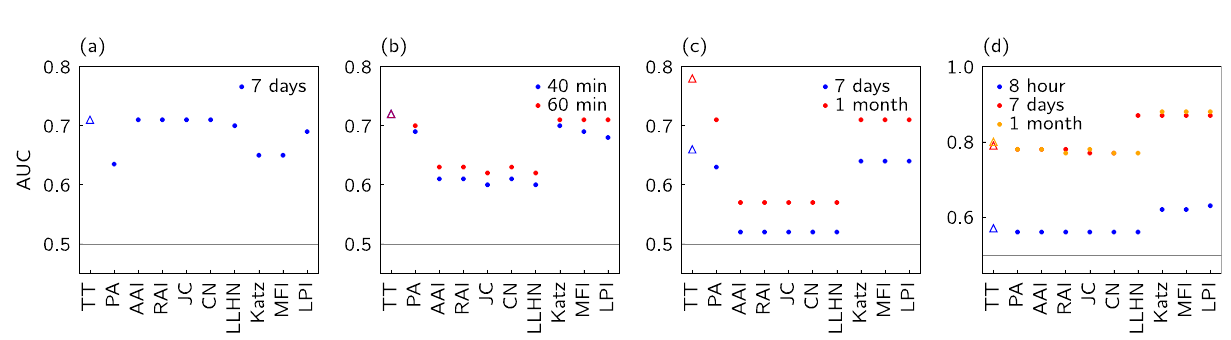
Figure 7. The area under the curve (AUC) results for four temporal networks constructed from real data sets: ( a ) Turkish Shareholder networks, ( b ) Hypertext networks, ( c ) College Message networks, ( d ) Email networks. The results compare ten different methods of Table 2 including our TT algorithm denoted by the ‘triangle’ symbol. For networks ( b – d ), we show the results for different time scales (windows). See Table 2 for abbreviations used in indicate link prediction